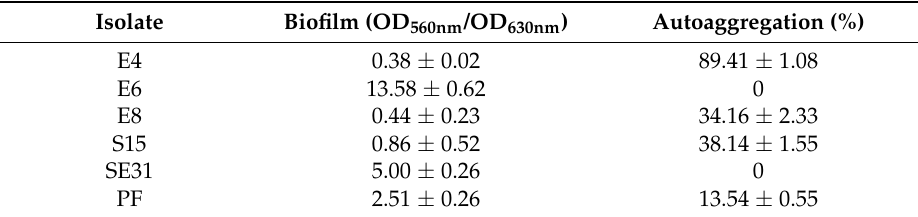
Table 7. Biofilm and autoaggregation formation ability of endophytic bacteria with potential for plant growth